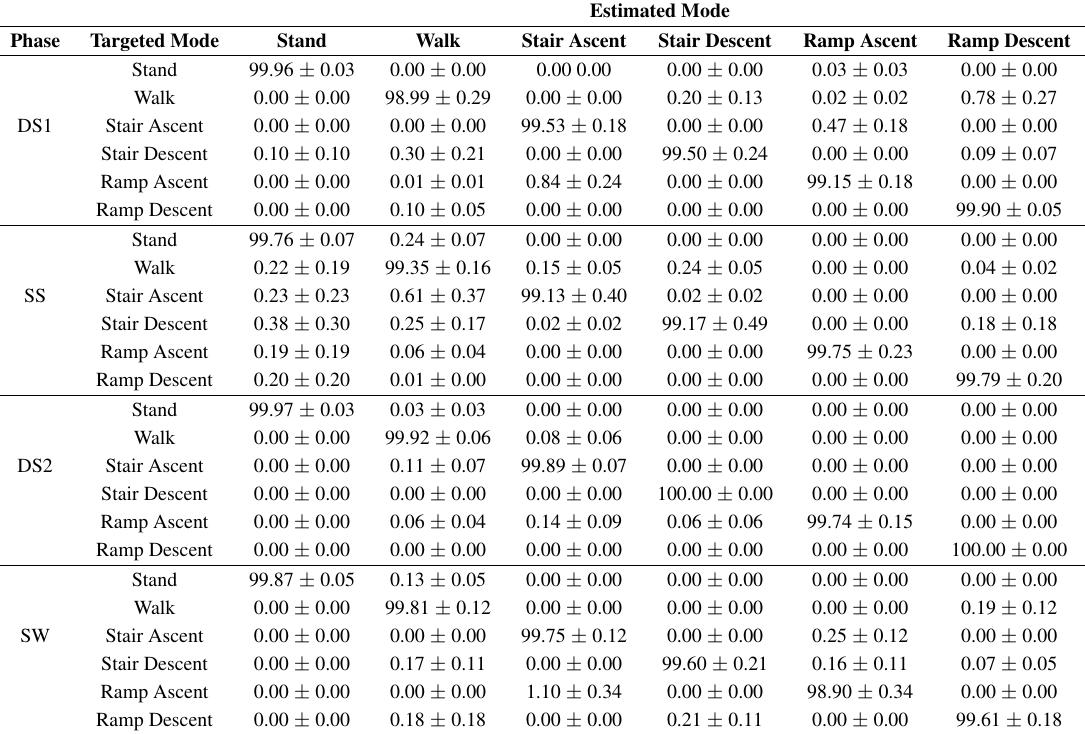
Table 2. Confusion Matrix (Mean (cid:6) SEM) for Seven Able-bodied Subjects in Steady Locomotion Periods